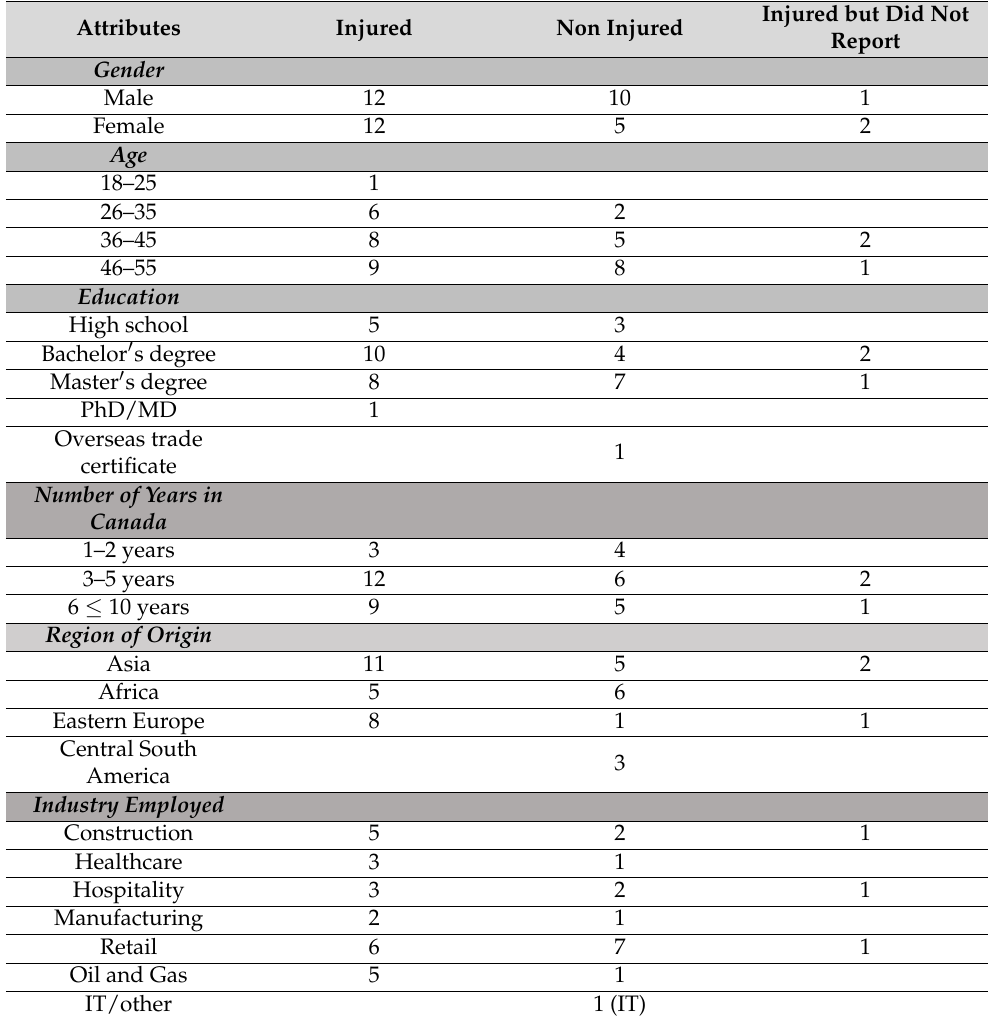
Table 1. Socio-demographics of